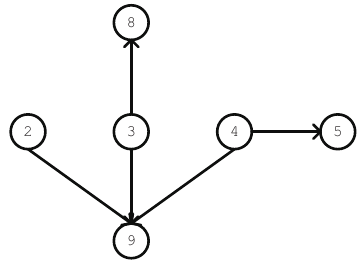
Figure 4. Subgraph of Data Dependence